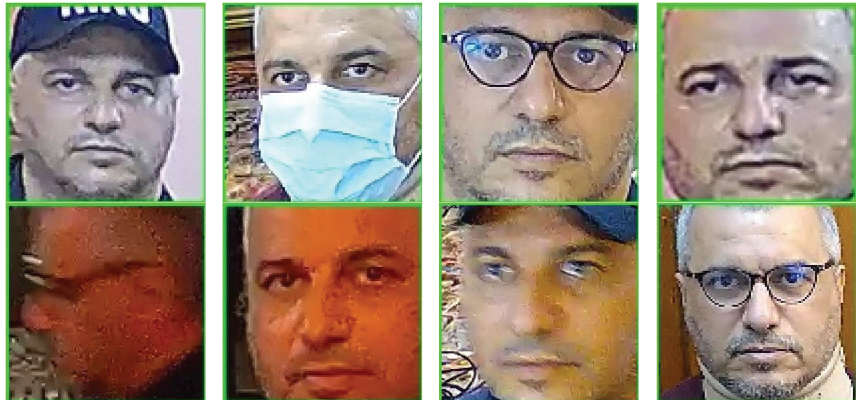
Figure 3: Faces with nonpermission